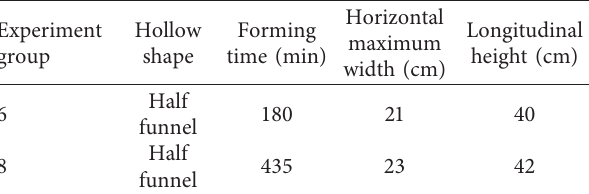
Figure 13: Effect of phase position of loss channel and pipeline. Table 6: Experiment 6 and 8 cavity parameter Table 6.